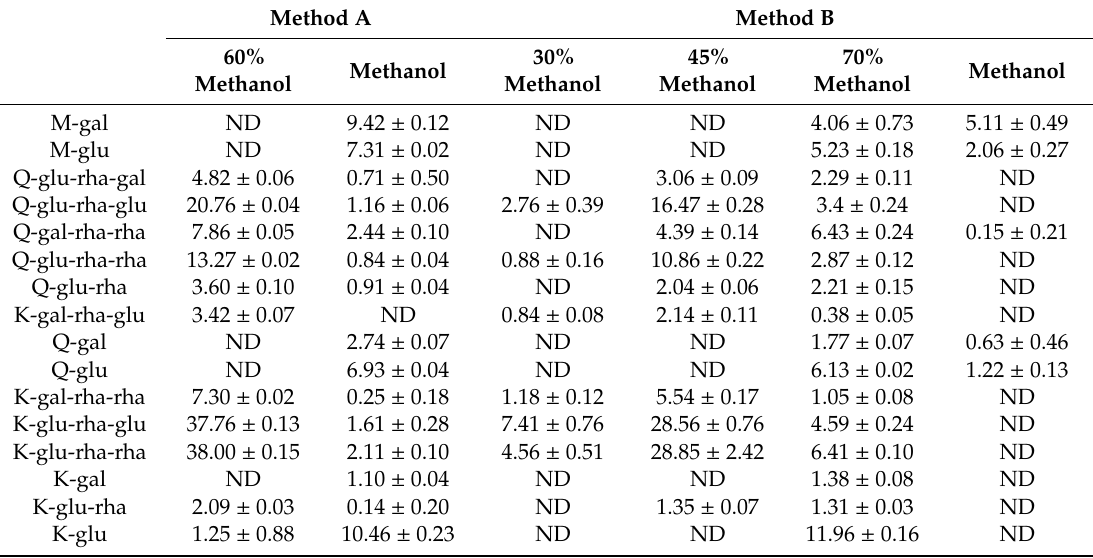
Table 2. The e ff ect of elution method on the composition of flavonol glycosides ( µ g /